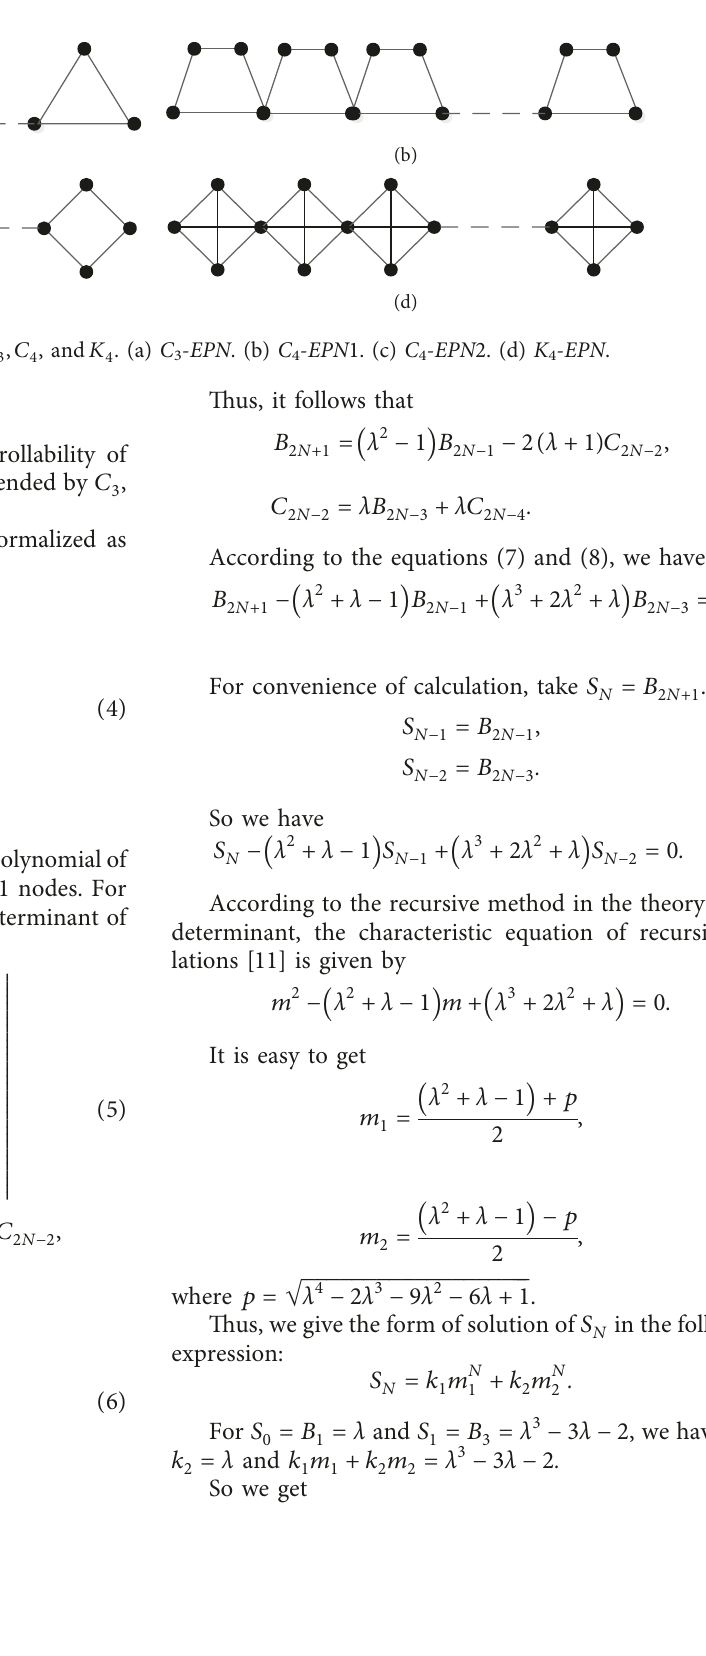
Figure 2: Construction of extended-path networks. (a) Path networks. (b) Extended-path networks.